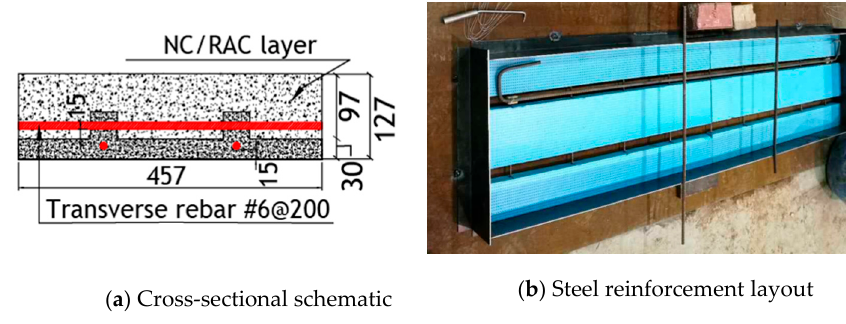
Figure 3. Details of deck type B (units in mm).